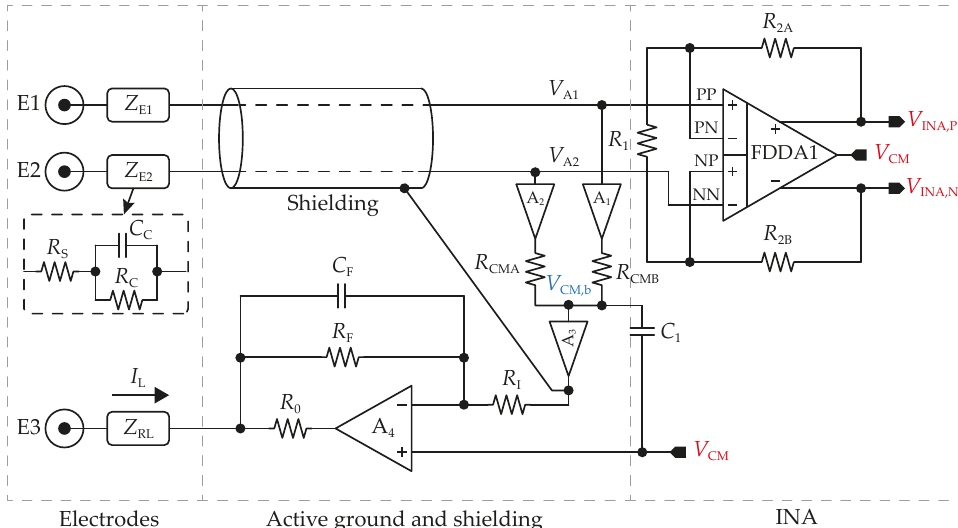
Figure 3. The topology of the proposed input part of the AFE includes active ground and shielding